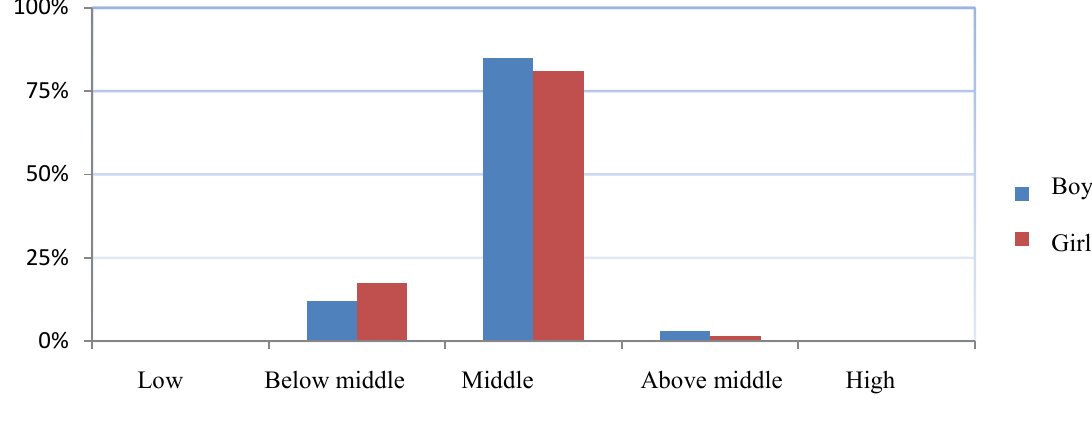
Fig. 3. Distribution of 1 st year technical specialties’ students of SumDU by levels of physical